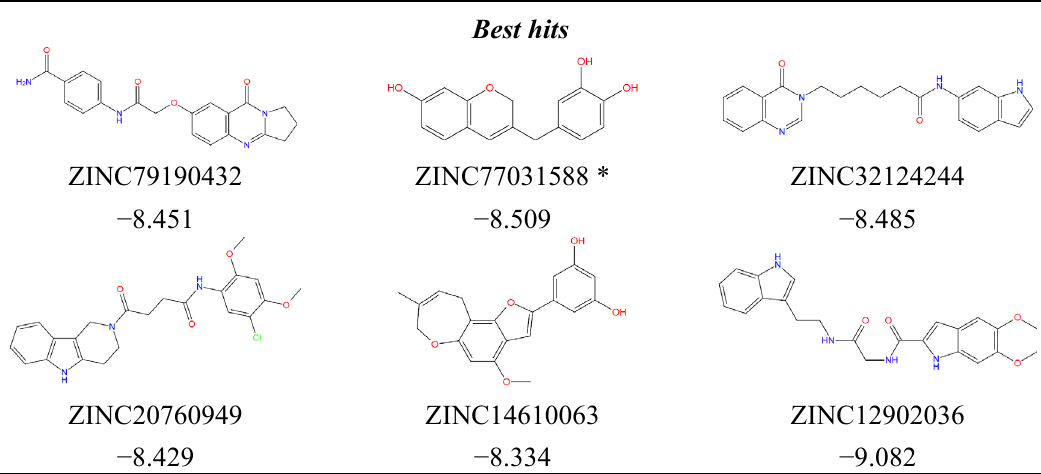
Table 5. 2D structure of the best hits identified into the natural database and filtered according to BRACO-19 G-score after their molecular recognition against 3CE5